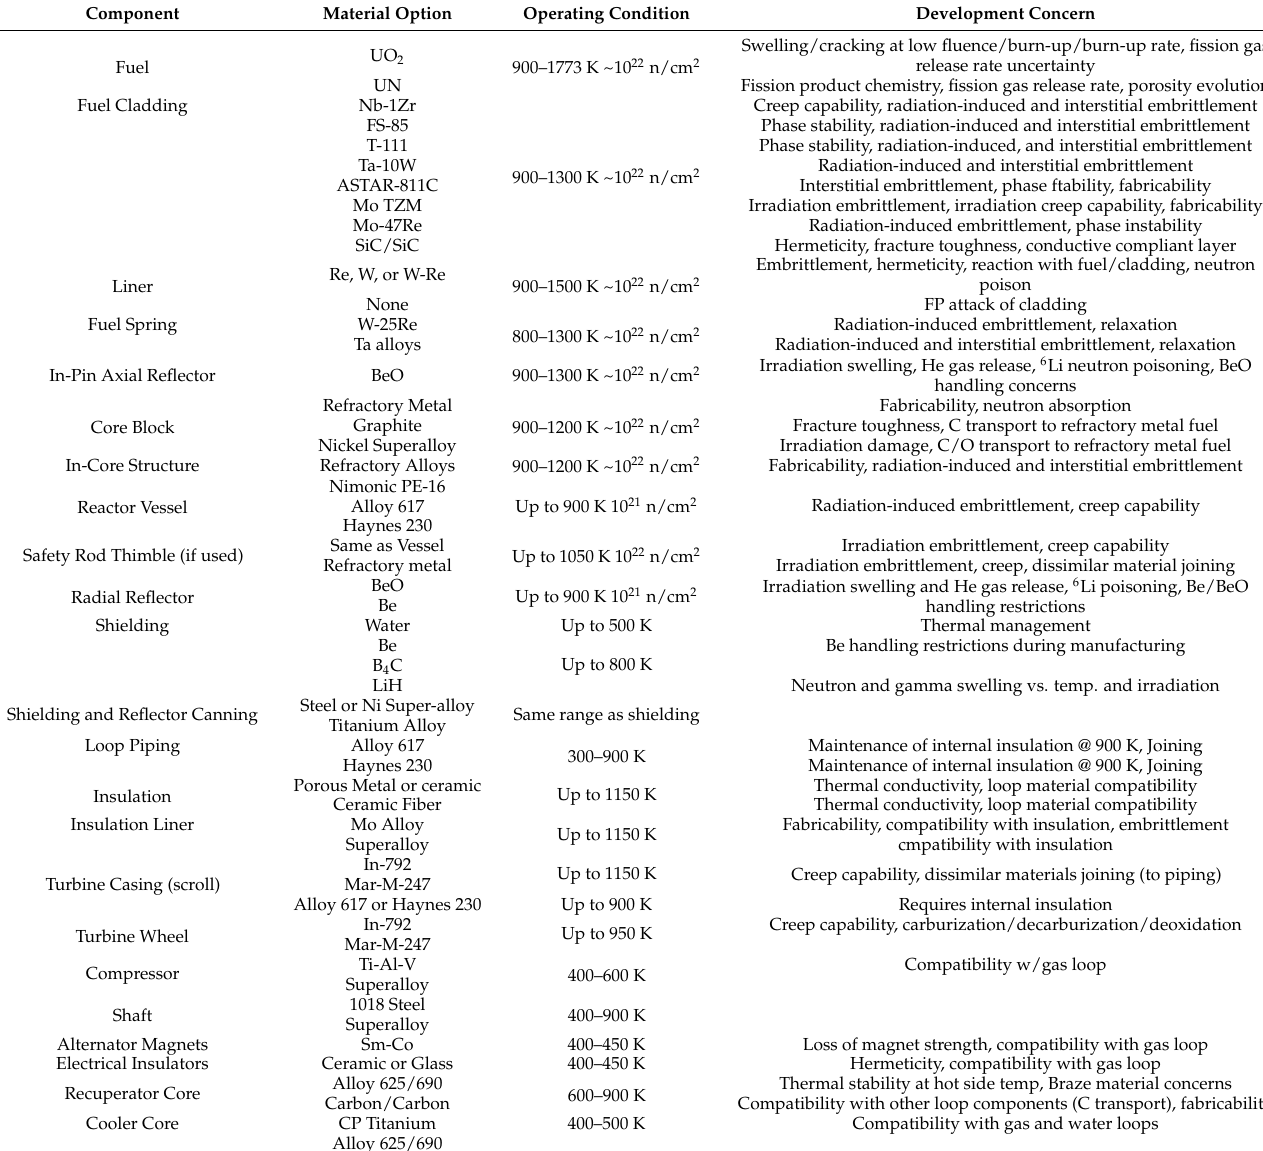
Table 3. List of materials envisioned for use in the Prometheus